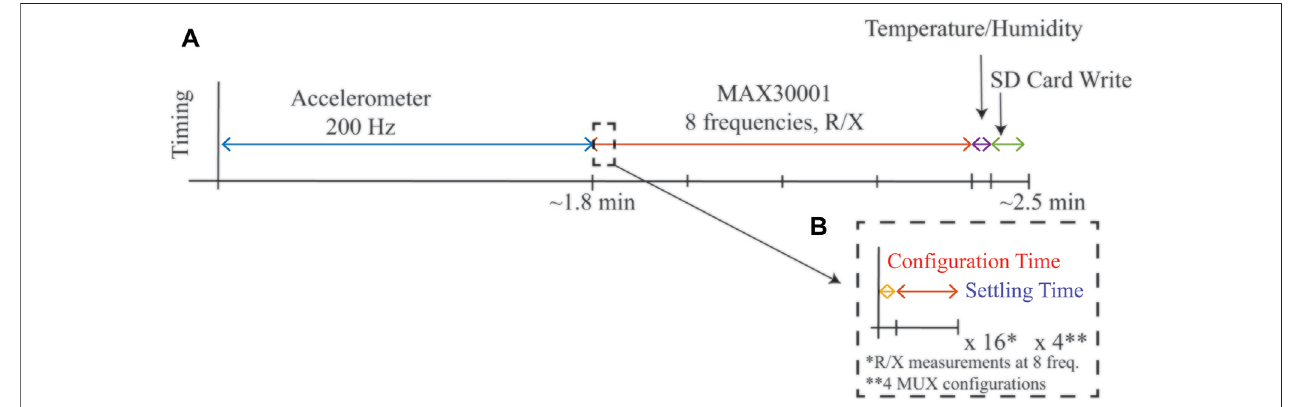
FIGURE3|(A) Timingofacompletecycleofmeasurementsfromthewearable system duringrun-time and (B) highlightofcon fi guration and settling time required for MAX30001 sensor for single frequency